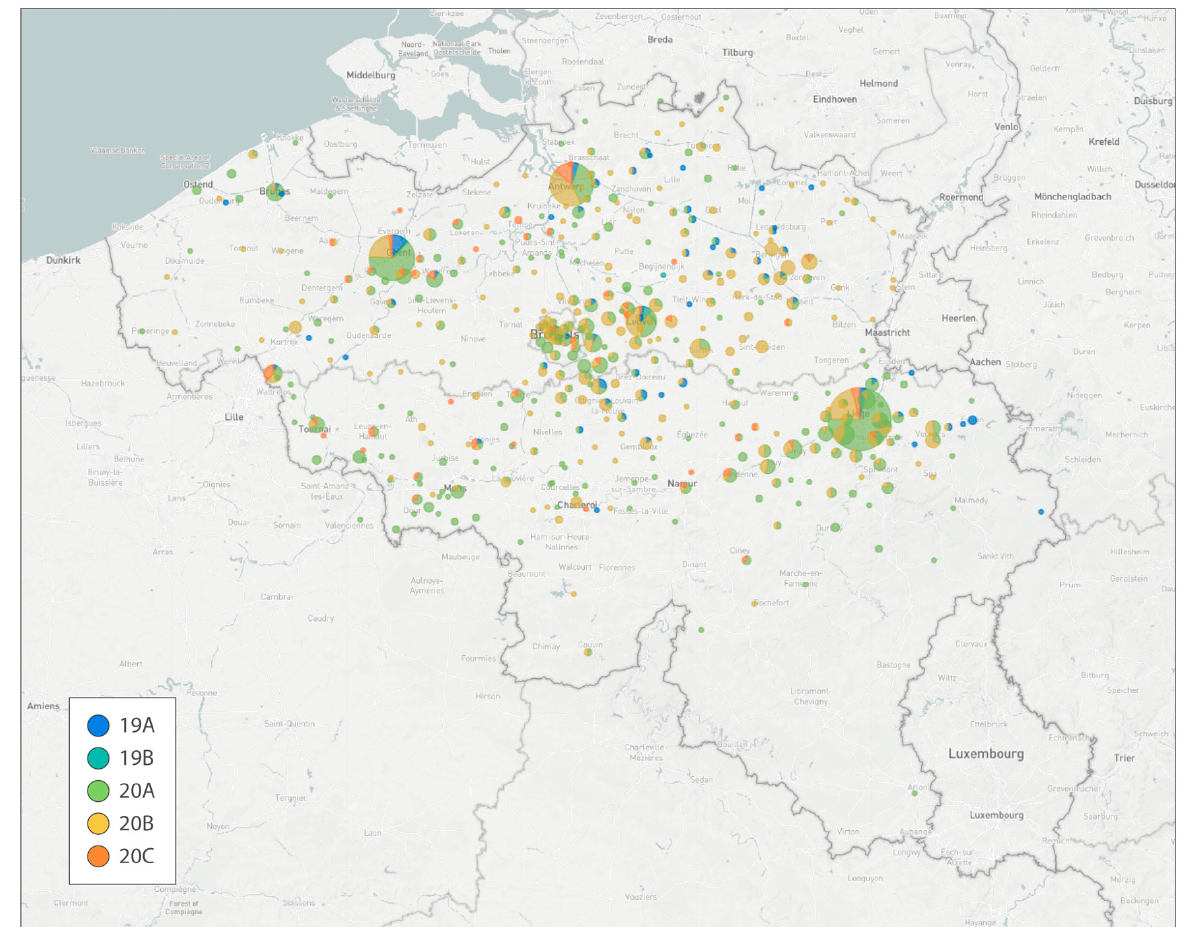
Figure 2. First publicly available Nextstrain build for Belgium, released on 8 January 2021 (just before the Alpha variant was detected in Belgium—or at least before any genomes from Alpha were available). In cases where GDPR prevents sharing the patient’s actual municipality of residence the sequencing center’s location was used, leading to larger numbers for the cities of Leuven, Liège, Ghent, and Antwerp. Pie charts are colored according to the SARS-CoV-2 clades defined in Nextstrain. Several studies focused on very specific settings to study SARS-CoV-2 infections among Belgian residents. At the beginning of May 2020, 22 out of 70 Belgian soldiers deployed to a military education and training center in Maradi, Niger, developed mild COVID-19 compatible symptoms [23]. Immediately upon their return to Belgium, and two weeks later, all seventy soldiers were tested for SARS-CoV-2 RNA and antibodies. Nine soldiers had at least one positive COVID-19 diagnostic test result. Five of them exhibited COVID-19 symptoms (mainly anosmia, ageusia, and fever), while four were asymptomatic. recent common ancestor with African origin and that the Belgian military service men